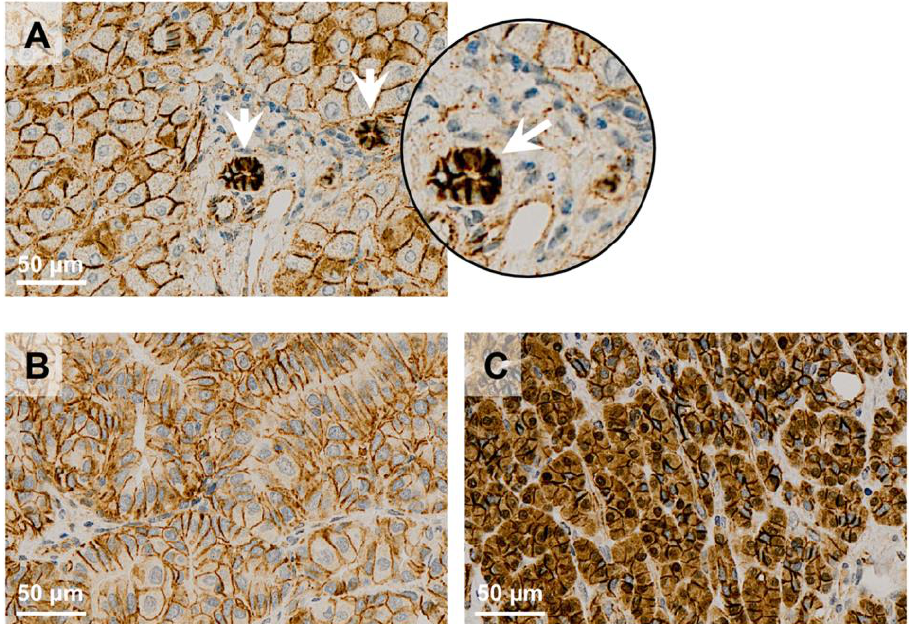
Figure 2. β -catenin immunohistochemistry showing basolateral membrane staining in normal adult human liver hepatocytes ( A ), with an evident greater intensity in bile duct cells (( A ), arrows). Absence of β -catenin nuclear immunoreactivity in CCA cells due to Wnt/ β -catenin signaling pathway inactivation ( B ). Strong nuclear and cytoplasmic β -catenin staining in CCA cells with Wnt/ β -catenin signaling pathway activation ( C ). Anti- β -catenin antibody clone 17C2 (Leica Biosystems) was used